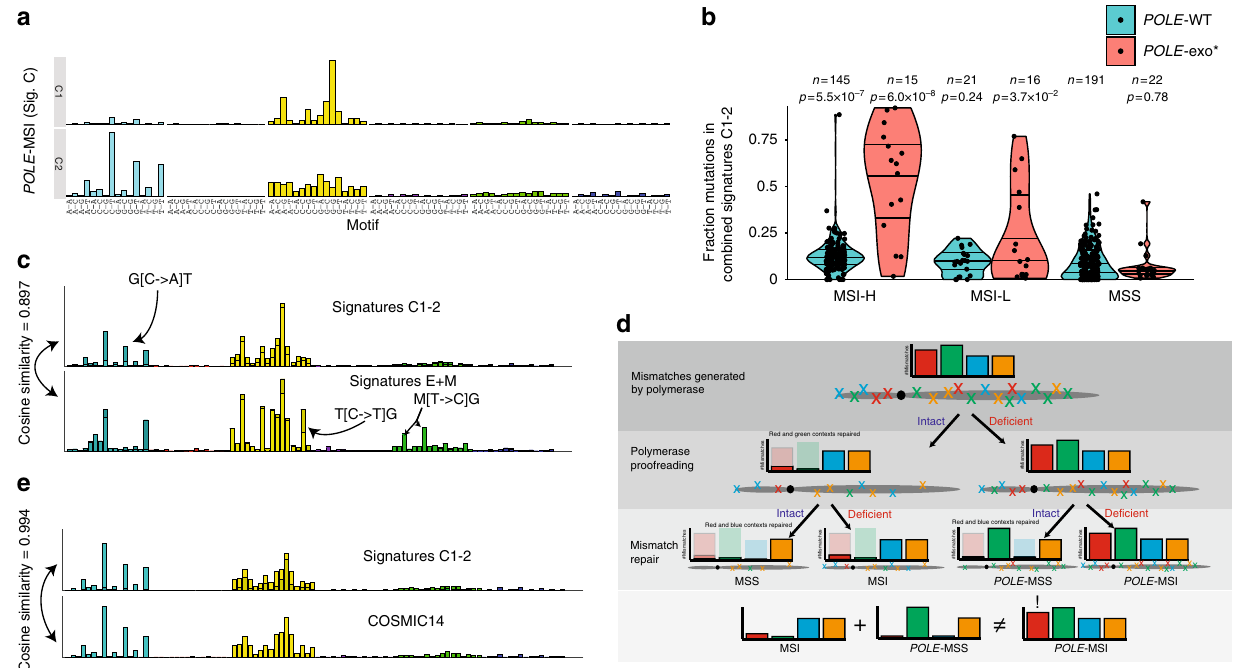
Fig. 3 Identi fi cation of mutational signatures associated with paired loss of POLE proofreading and MMR. a SignatureAnalyzer identi fi ed two mutational signatures associated with paired POLE -exo mutations and MSI (C1 and C2). b The fraction of mutations across all cases assigned to signatures C1 and C2, segregated by POLE -exo* and MSI status. The distribution of each group is compared to that of polymerase wild-type MSS samples using a one-tailed rank- sum test. Horizontal lines within each group represent quartile values. c The fi ve signatures of individual repair defects (signatures M1, M2, E1, E2, and E3) were combined to maximize cosine similarity to a combination of the two signatures of paired defects (C1 and C2). Each set of signatures retains several unique peaks, highlighted with arrows. M represents either A or C nucleotides. d Model highlighting the non-additive mutational signature contributions of combined mutational processes. e A linear combination of the signatures C1 and C2 closely resembles COSMIC signature